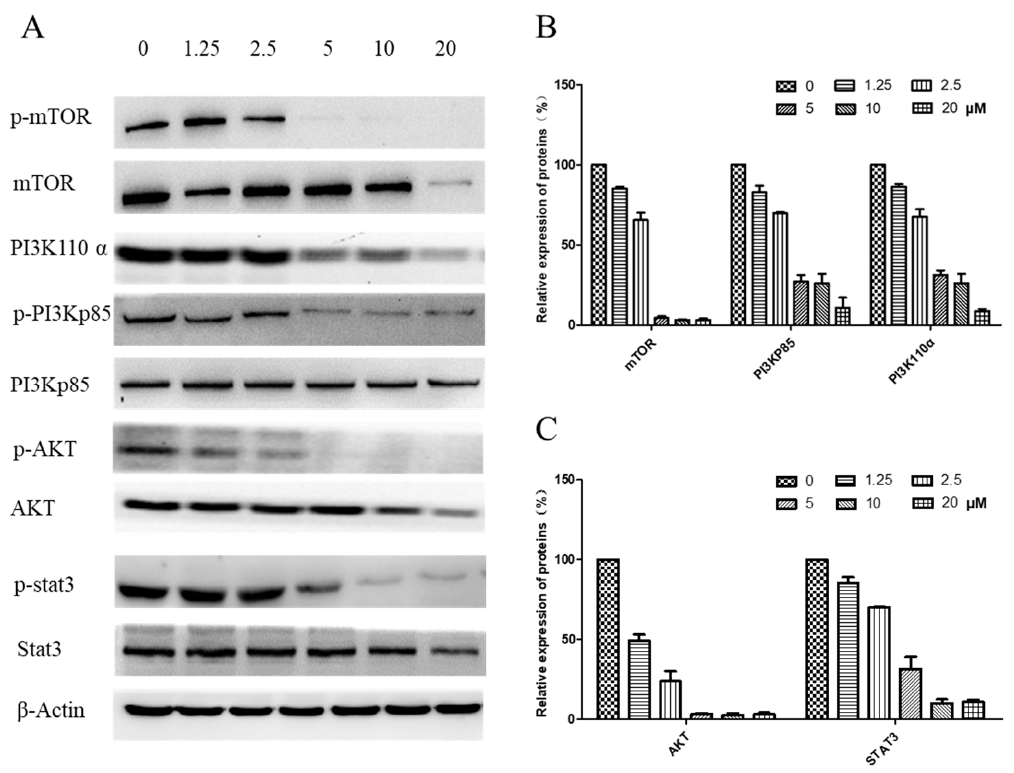
Figure 8. E ff ects of arnicolide D on the PI3K / AKT pathway (48 h). CNE-2 cells were treated with arnicolide D at concentrations of 1.25–20 µ M for 48 h, and cell lysates were harvested and subjected to Western blot analysis using antibodies against mTOR and p- mTOR (Ser 2481 ), PI3K p110 α , PI3K p85 and p- PI3K p85 (Tyr 458 ), AKT and p- AKT (Ser 473 ), and STAT3 and p-STAT3 (Tyr 705 ). β -actin was used as an internal control. ( A ) Western blot results after 48 h treatment. ( B , C ) Bar graphs showing quantified relative expression of the proteins. Data are expressed as means ± SD.